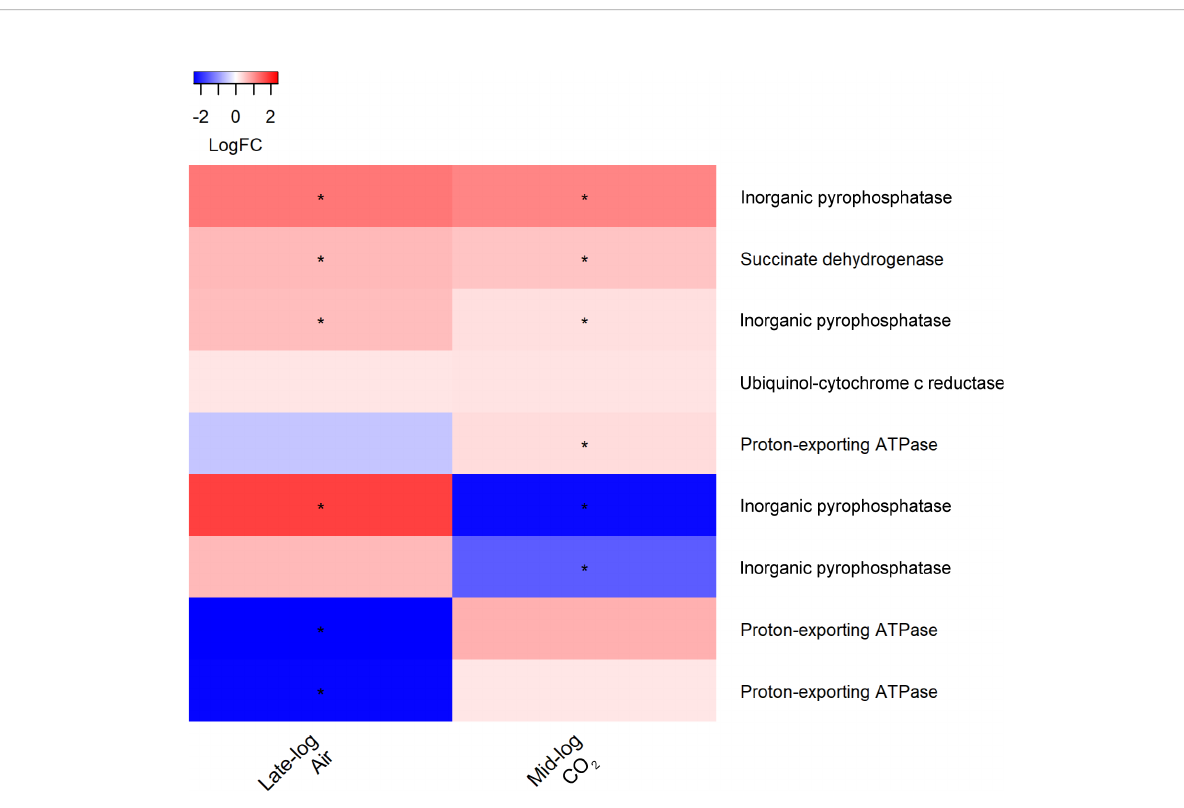
FIGURE 10 Heat map of differentially expressed transcripts encoding enzymes involved in oxidative phosphorylation in S. obliquus grown in the presence of switchgrass during late-log and mid-log phase growth in ambient (i.e., air) and 1% CO 2 , respectively. Differential expression is presented from a mean of triplicate samples as the log fold change of transcripts from cultures containing switchgrass compared to cultures of the algae alone. Stars indicate an adjusted p-value of less than